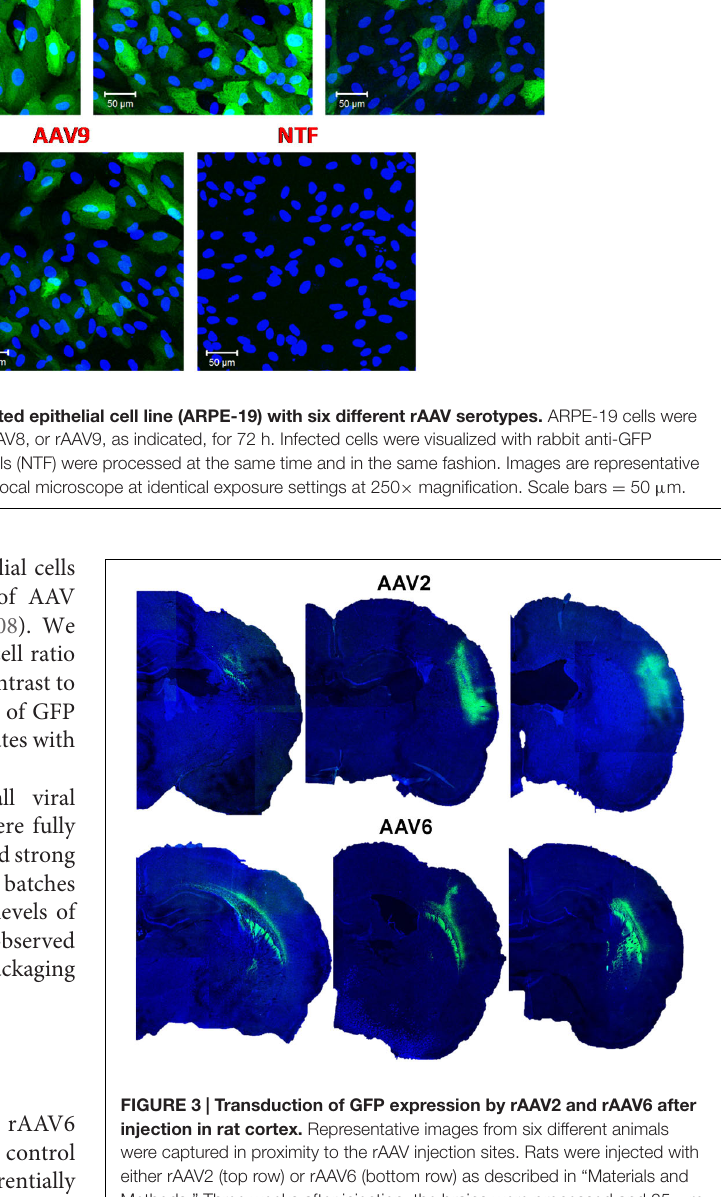
FIGURE 3 | Transduction of GFP expression by rAAV2 and rAAV6 after injection in rat cortex. Representative images from six different animals were captured in proximity to the rAAV injection sites. Rats were injected with either rAAV2 (top row) or rAAV6 (bottom row) as described in “Materials and Methods.” Three weeks after injection, the brains were processed and 25- µ m coronal sections were stained with anti-GFP antibody and counterstained with DAPI. Fluorescence signals were captured using a Leica TCS SPE confocal microscope at 15 × magnification and a series of six individual fields per each brain were stitched together using the ImageJ